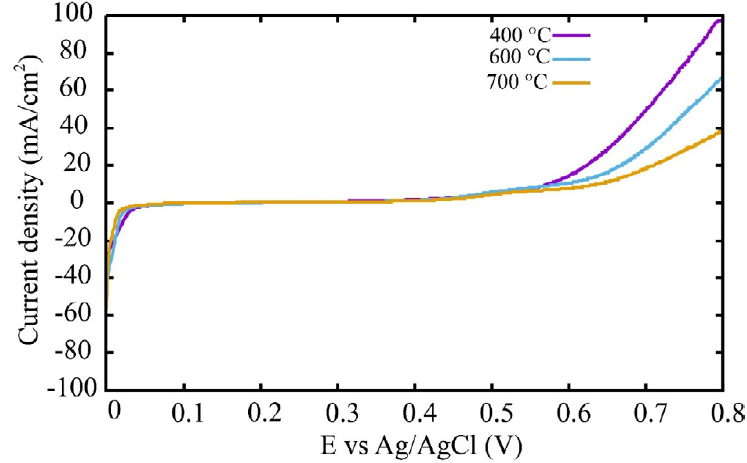
Fig. 3. LSV polarization curves of the NiO nanoparticles synthesized at the different annealing temperatures.